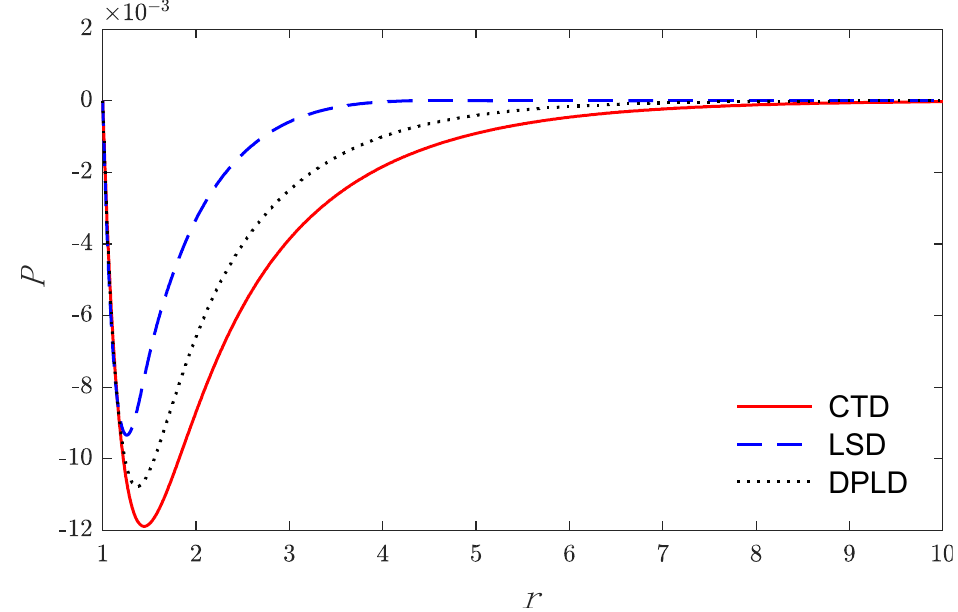
Figure 7. The chemical potential variations 𝑃 via the redial distance 𝑟 for three models.